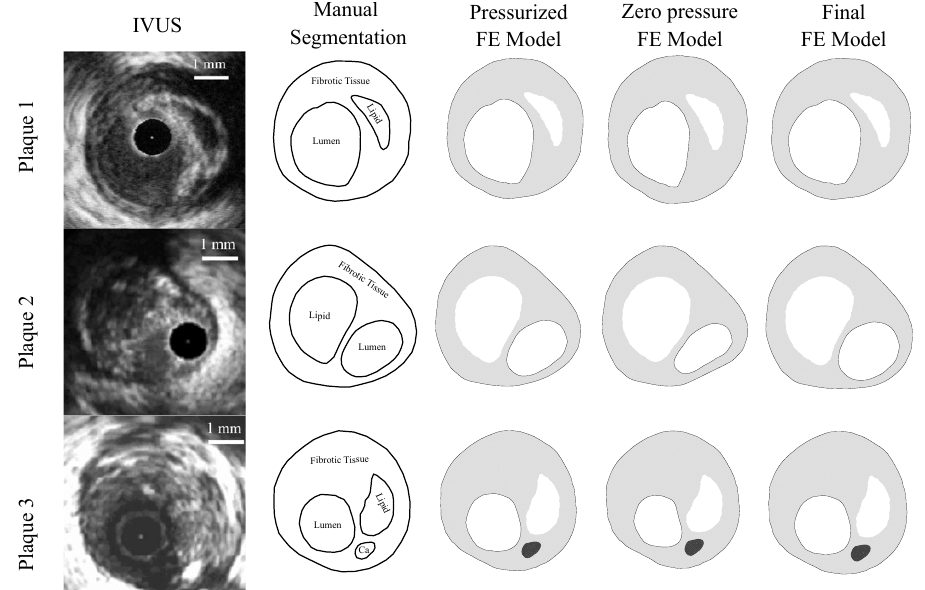
Figure 3. The first column presents IVUS images [35] of the three different plaques; the second column is the manual segmentation performed by a cardiologist [35]; the third column is the IVUS reconstruction in Abaqus of the pressurized geometry; the fourth column shows the plaque models with zero-pressure geometry in Abaqus. These geometries were used to initiate the FE simulations. The fifth column is the final FE model after applying an internal pressure of 115 mmHg to the previous